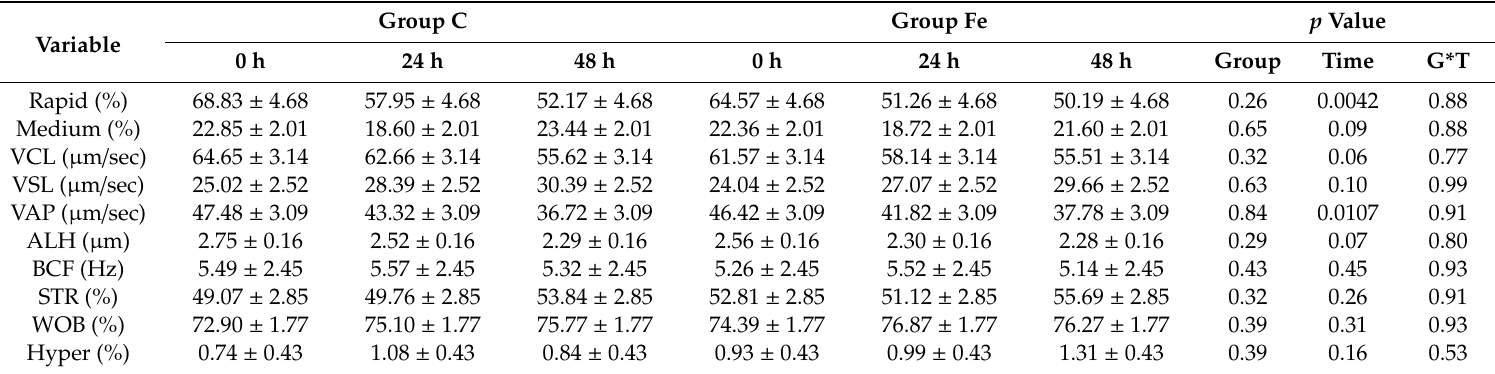
Table 1. Computer-assisted sperm analyzer (CASA) kinematic parameters (mean ± SEM) of extended boar semen samples at 0, 24 h and 48 h of storage post treatment with Fe 3 O 4